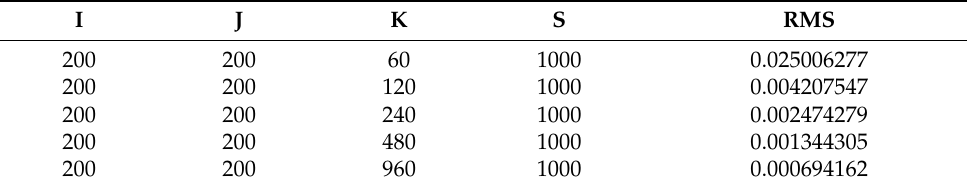
Table 3. Convergence for different mesh sizes along the oZ axis.